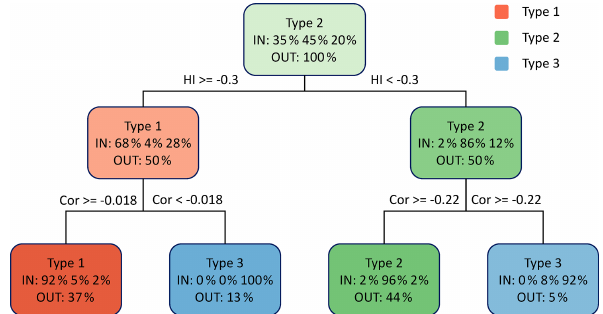
Figure 5. Decision tree for the classification of groundwater re- sponses in relation to the streamflow responses to precipitation events into three response types. Responses are split based on the hysteresis index (HI) and Spearman correlation coefficient (Cor), as shown by the expressions on the horizontal lines between nodes. Each node is coloured based on the predominant response type, while the colour intensity denotes the purity of the classification. Node text shows the predominant response type, the percent of re- sponses of each type at that node in the input database (IN) and the percent of the total number of responses at that node (OUT).